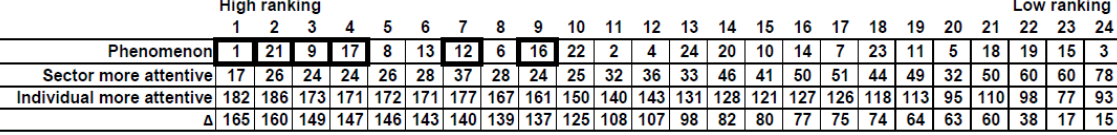
Table 4 Comparison between the responses to aspect 3: about the sector’s attention and the responses to aspect 4: about the individual respondent’s attention . All aspects can be seen in Figure 2.